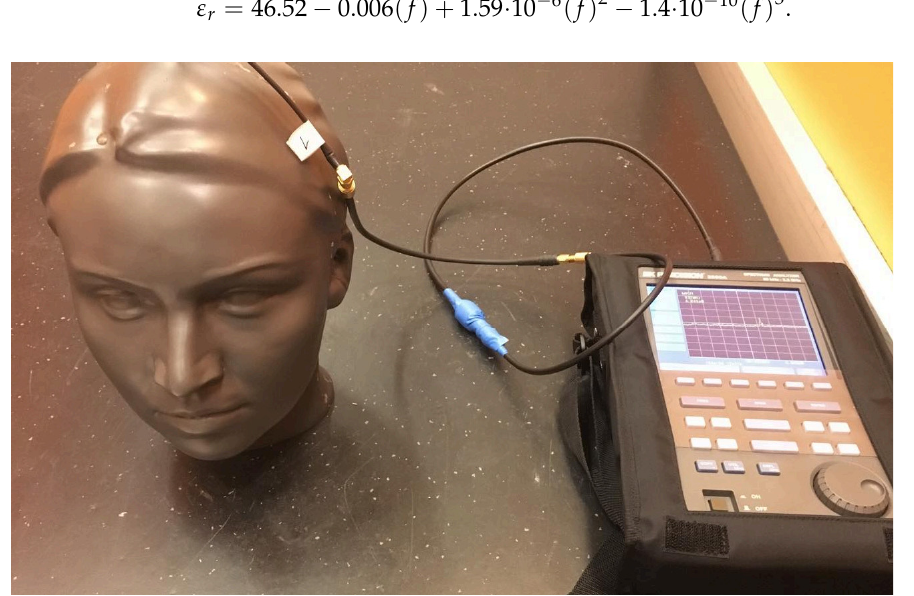
Figure 6. Human head phantom (made using rapid prototyping technology) for microwave EMF measurements usage.